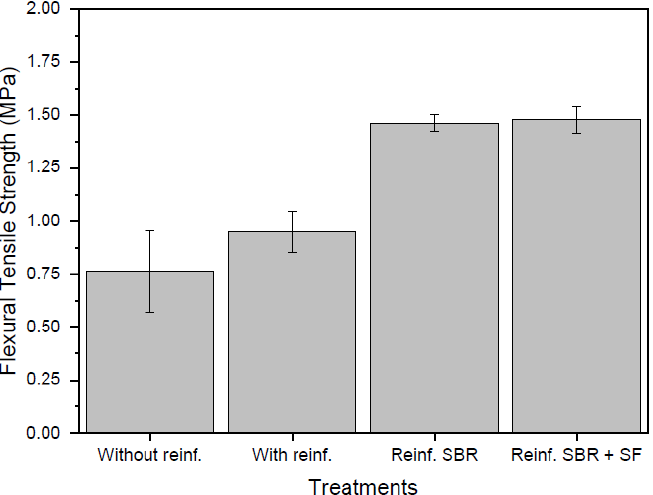
Figure 11. Flexural tensile strength of the composites.